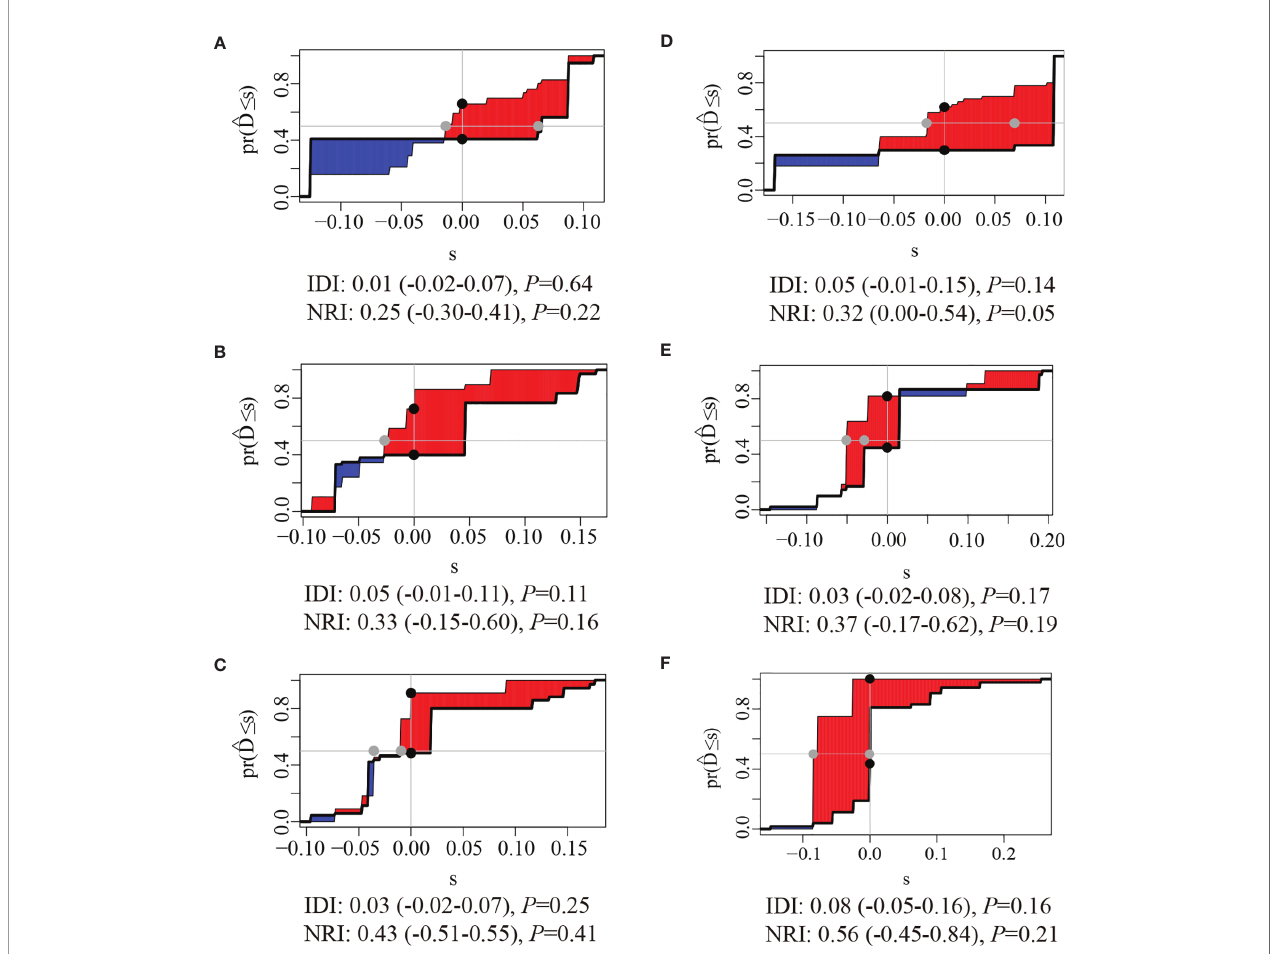
FIGURE 3 | Integrated Discrimination Improvements (IDI) and Net Reclassi fi cation Index (NRI) of ModelB comparing to ModelA at (A) 1 year, (B) 2 years, and (C) 3 years after surgery in the training cohort and (D) 1 year (E) , 2 years, and (F) 3 years after surgery in the validation cohort. the red areas were greater than blue areas and the median value of NRI and IDI were all greater than zero, indicating that the predictive ability of ModelB may be better than